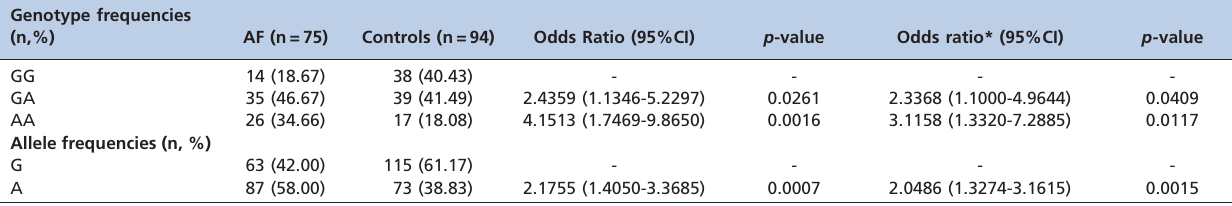
Table 2 - ACE 2350G/A genotype and allele frequencies in AF and control subjects. Genotype frequencies